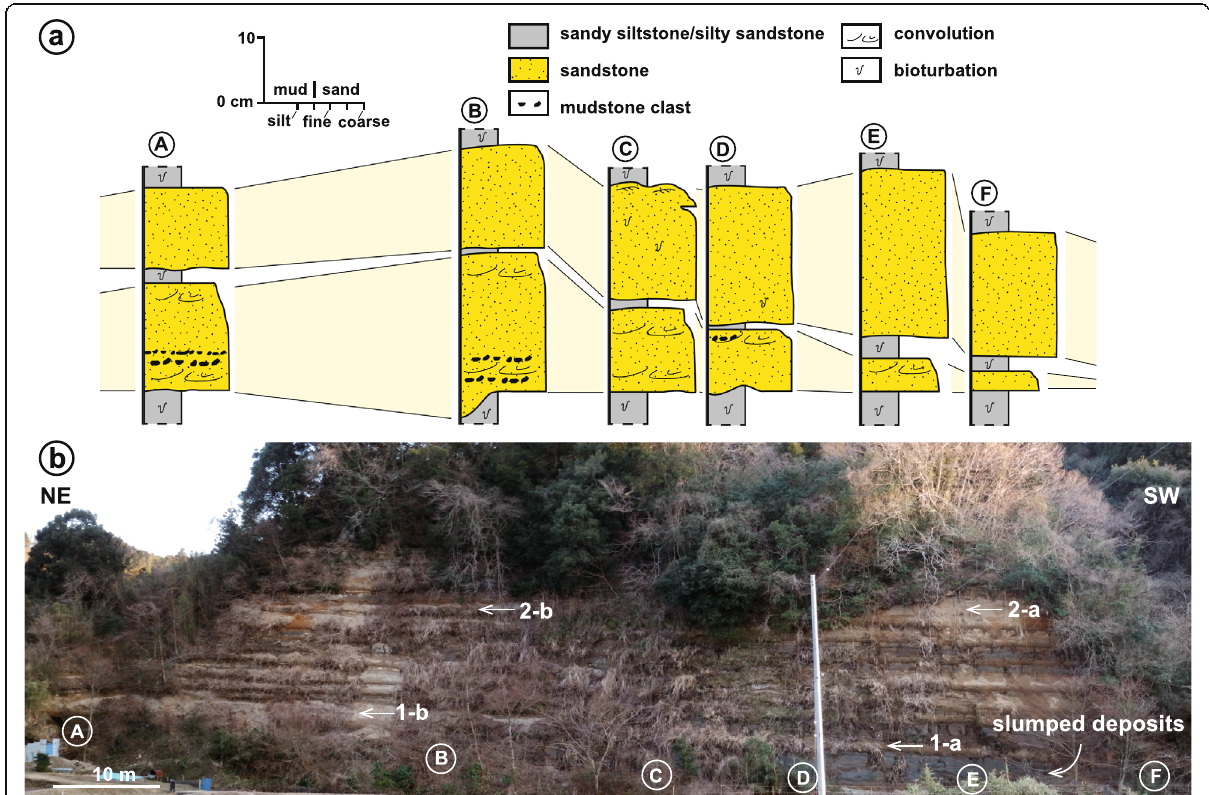
Fig. 6 a Downflow (= northeastward) variations in thickness and lithofacies features of thick- to very thick-bedded sandstones in PC4 of the Chonan Formation, Heizo, Ichihara City. b Outcrop photograph of PC4 of the Chonan Formation. A – F denote the locations of the measured sections (A – F) in a . Arrows 1-a and 1-b, and arrows 2-a and 2-b indicate downflow thickening and thinning of sandstone beds in the northeast, respectively. This outcrop (35° 21 ′ 01 ″ N, 140° 12 ′ 10 ″ E) is located about 400 m east of the location of section 6 in Fig.